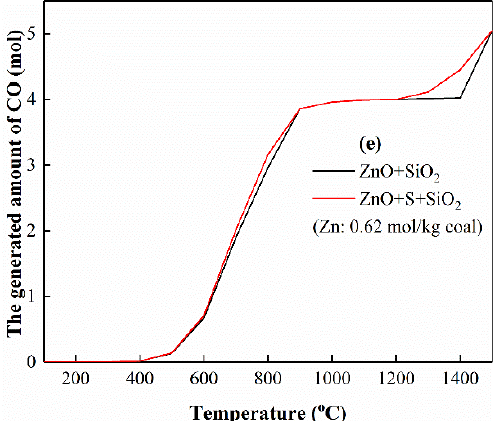
Figure 10. The thermodynamic equilibrium distributions of Zn ( a , c ), Si ( b , d ) and generated amount of CO ( e ) when Zn and Si coexist in the coal.